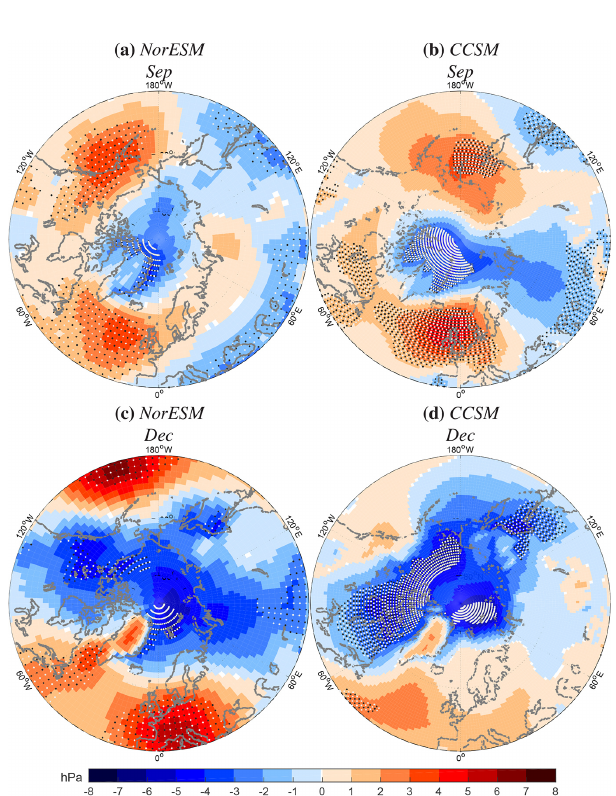
Figure 10. Changes in sea level pressure averages for September (upper row) and December (lower row) 2074–2100 compared to 1979–2005 following the RCP8.5 scenario in (a, c) NorESM and (b, d) CCSM. Alternating black and white dots mark regions of significant change at a 95% confidence